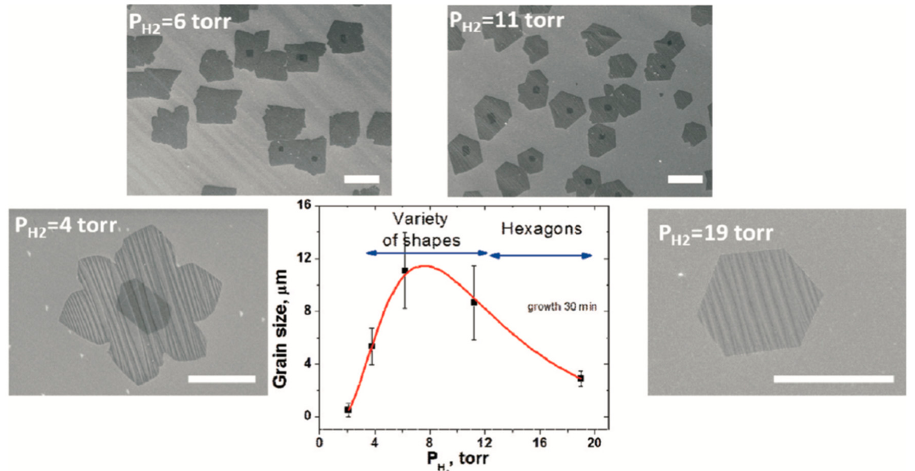
Figure 25. SEM images showing the morphology of the obtained graphene domains as a function of hydrogen partial pressure and its effect on grain size. Scale bars are 10 μ m (top two images) and 2 μ m (bottom two images) (reprinted with permission from [61]).